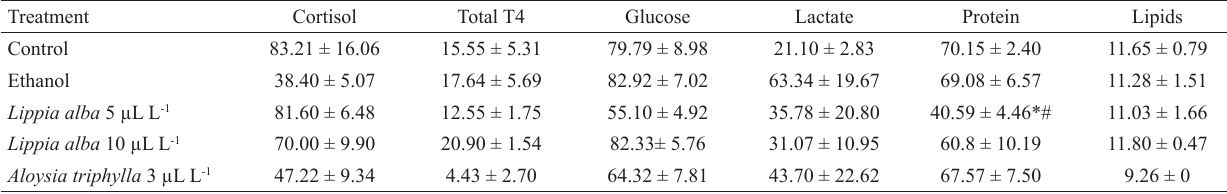
Tab. 1. Plasma levels of cortisol (µg dL -1 ), total T4 (µg dL -1 ), glucose (mg dL -1 ), lactate (mg dL -1 ), protein (mg mL -1 ) and lipids (mg mL -1 ) in Serrasalmus eigenmanni exposed to different concentrations of Aloysia triphylla and Lippia alba essential oils. * indicates a significant difference from control fish and # indicates a significant difference from ethanol-exposed fish, based on one-way ANOVA and Tukey tests (P <